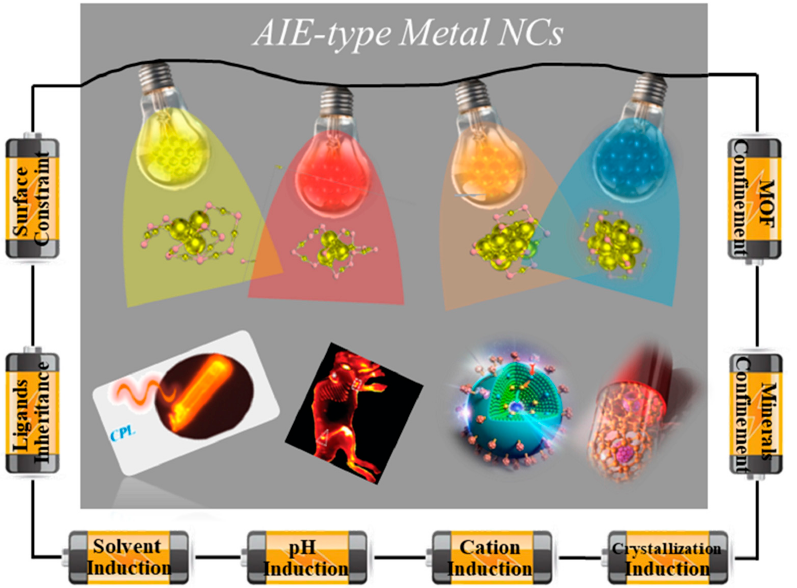
Figure 2. Schematic illustration of AIE-type metal NCs from the design strategies to the applications.